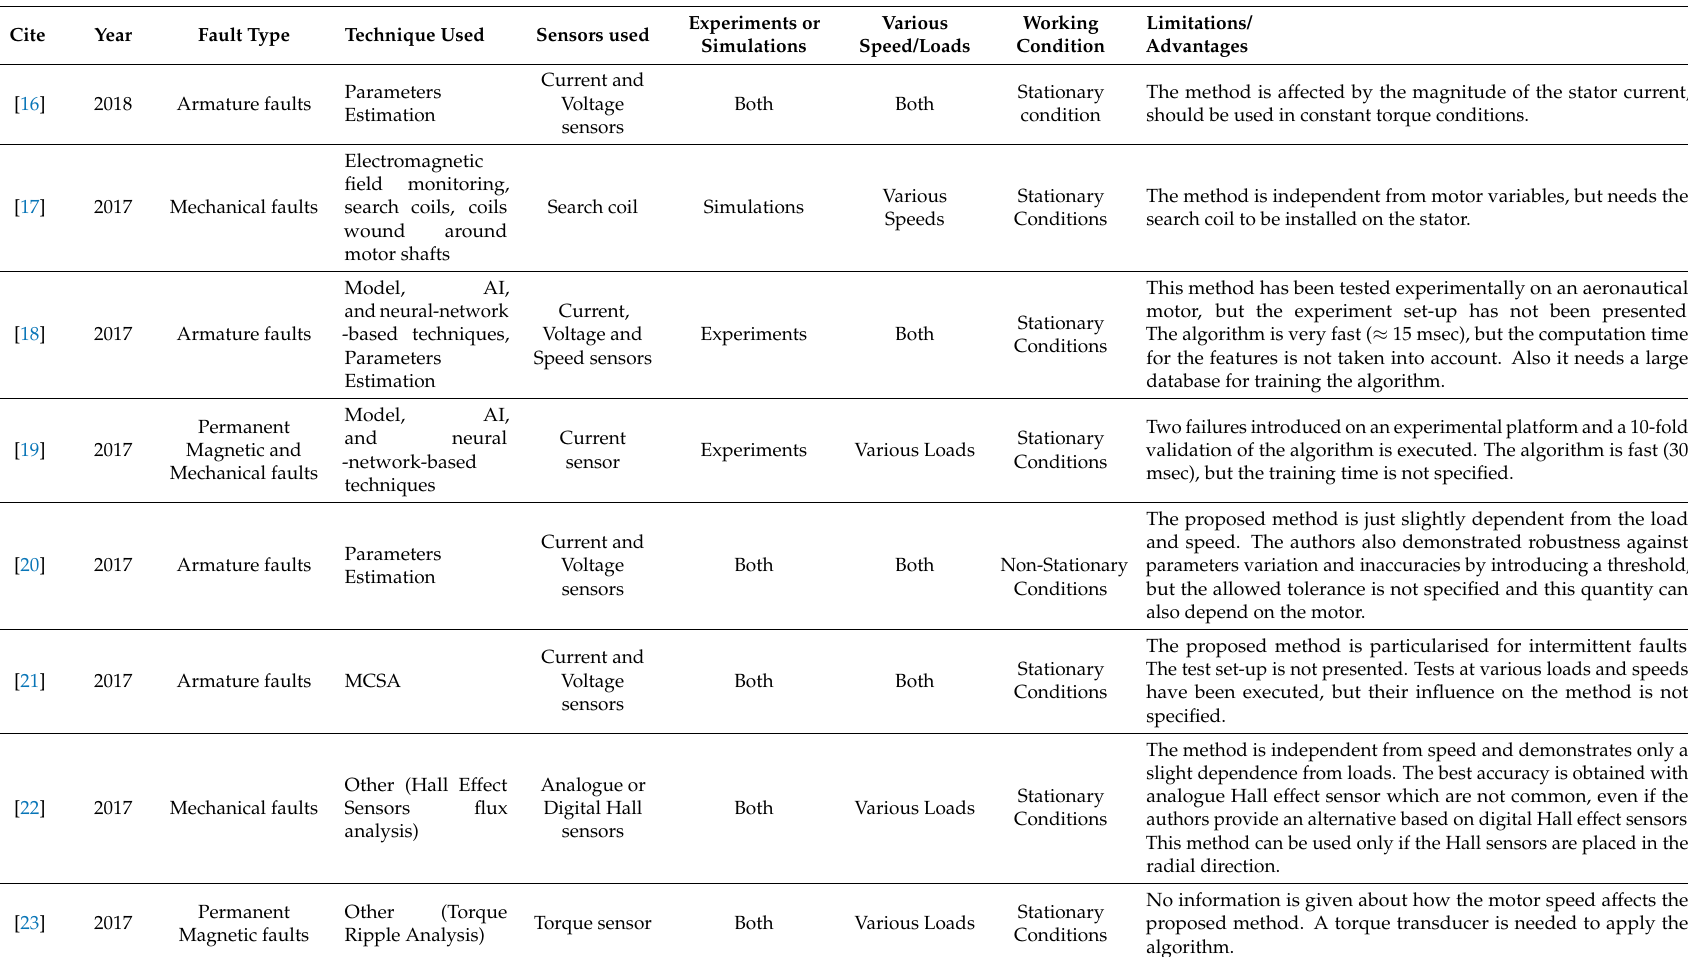
Table 2. Features table